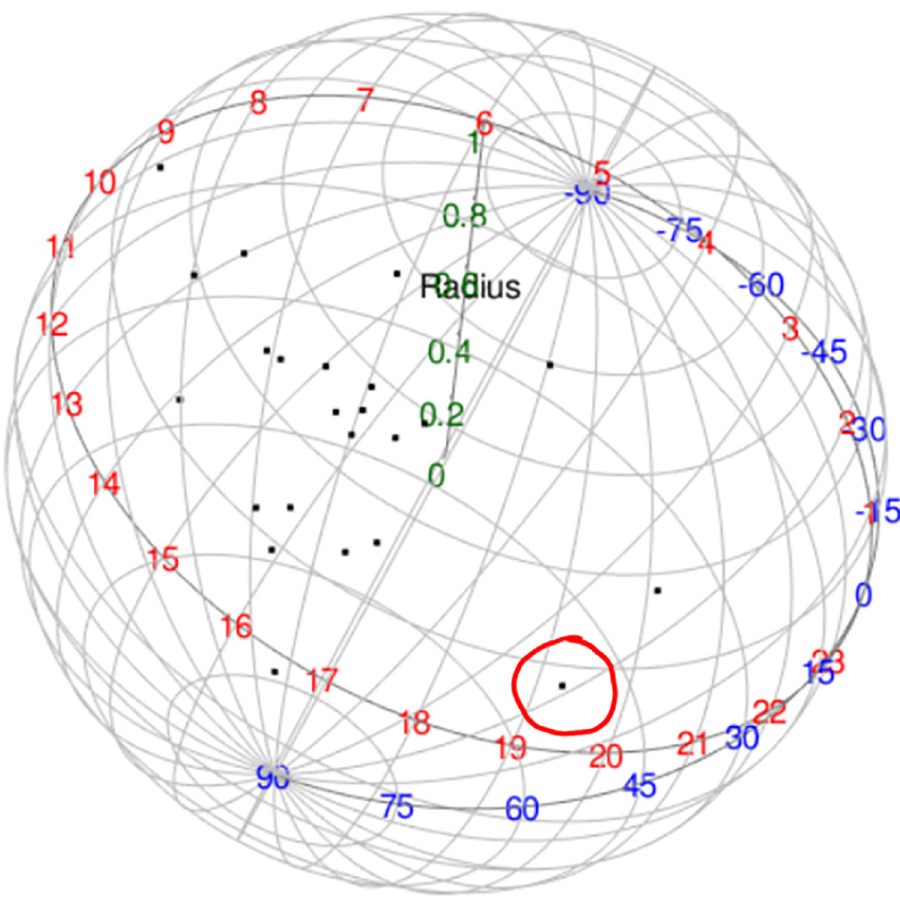
Fig 5. Spherical plot of eye